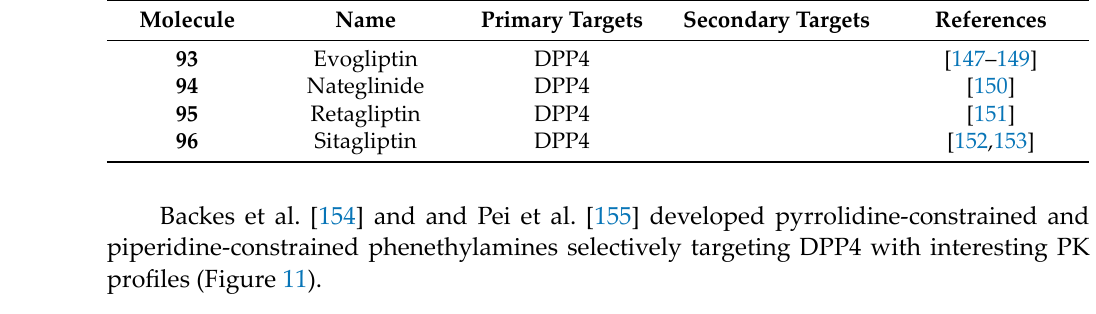
Figure 11. 2-Phenylethyl-based DPP4 receptor ligands. Figure 11. 2‑Phenylethyl‑based DPP4 receptor ligands. Table 3. DPP4 medicinal chemistry leads.